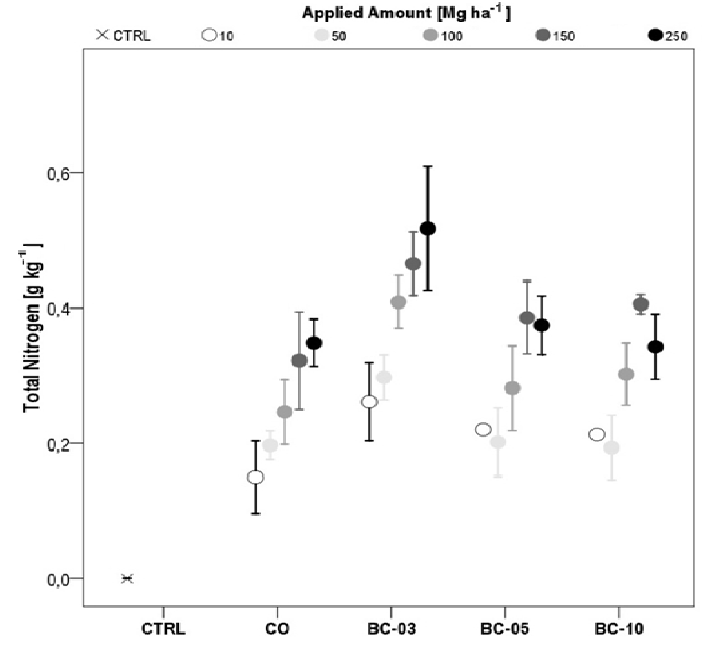
Figure 5. Total nitrogen (N ) in g kg −1 on sandy ( a ) and loamy substrate ( b ) depicted for tot 5 treatments (CO = pure compost, BC-03 = compost with 3 kg Mg −1 w / w biochar, BC-05 = compost with 5 kg Mg −1 w / w biochar, BC-10 = compost with 10 kg Mg −1 w / w biochar) in five application amounts (10, 50, 100, 150, 250 Mg ha −1 ) versus control (CTRL = no amendment) ( n =